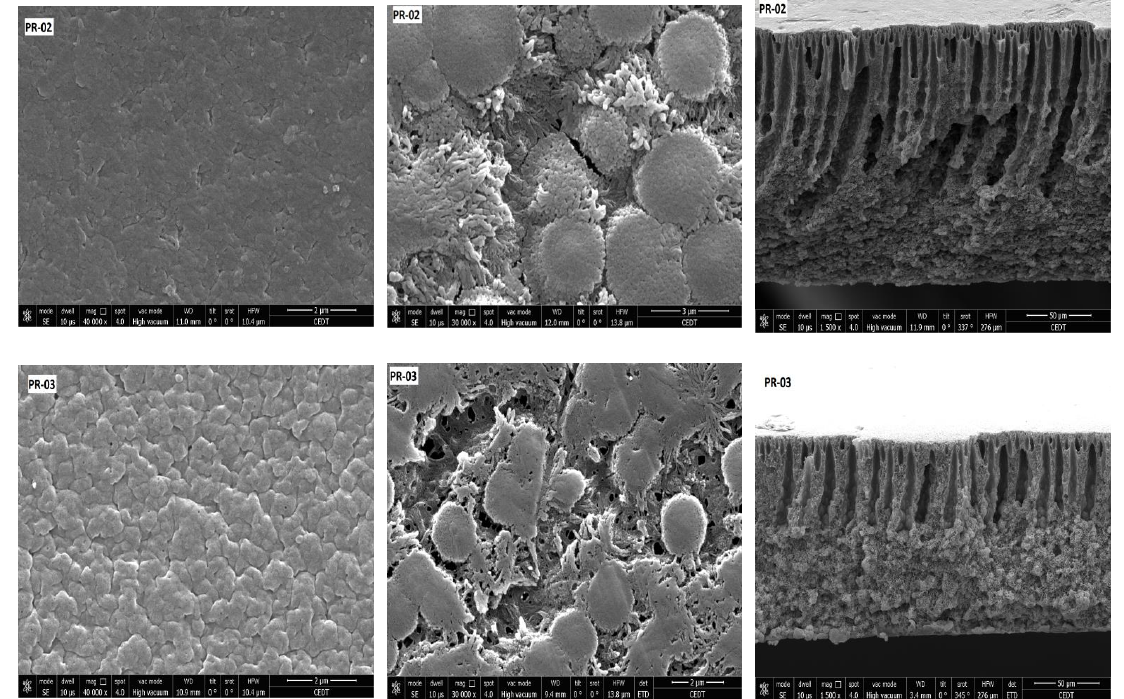
Figure 8. FESEM images of blended PVDF membranes films. Components of the dope solution: 20 wt % Solef ® 6020 PVDF homopolymer and Solef 90 ® 21015 PVDF copolymer, 80 wt % NMP as a solvent. Percentage of the copolymer in the overall PVDF blend: PR-01: 10%, PR-02: 20%, PR-03: 30%. Top surface (mag. 40,000) Bottom surface (mag. 30,000) Cross section (mag. 1500)